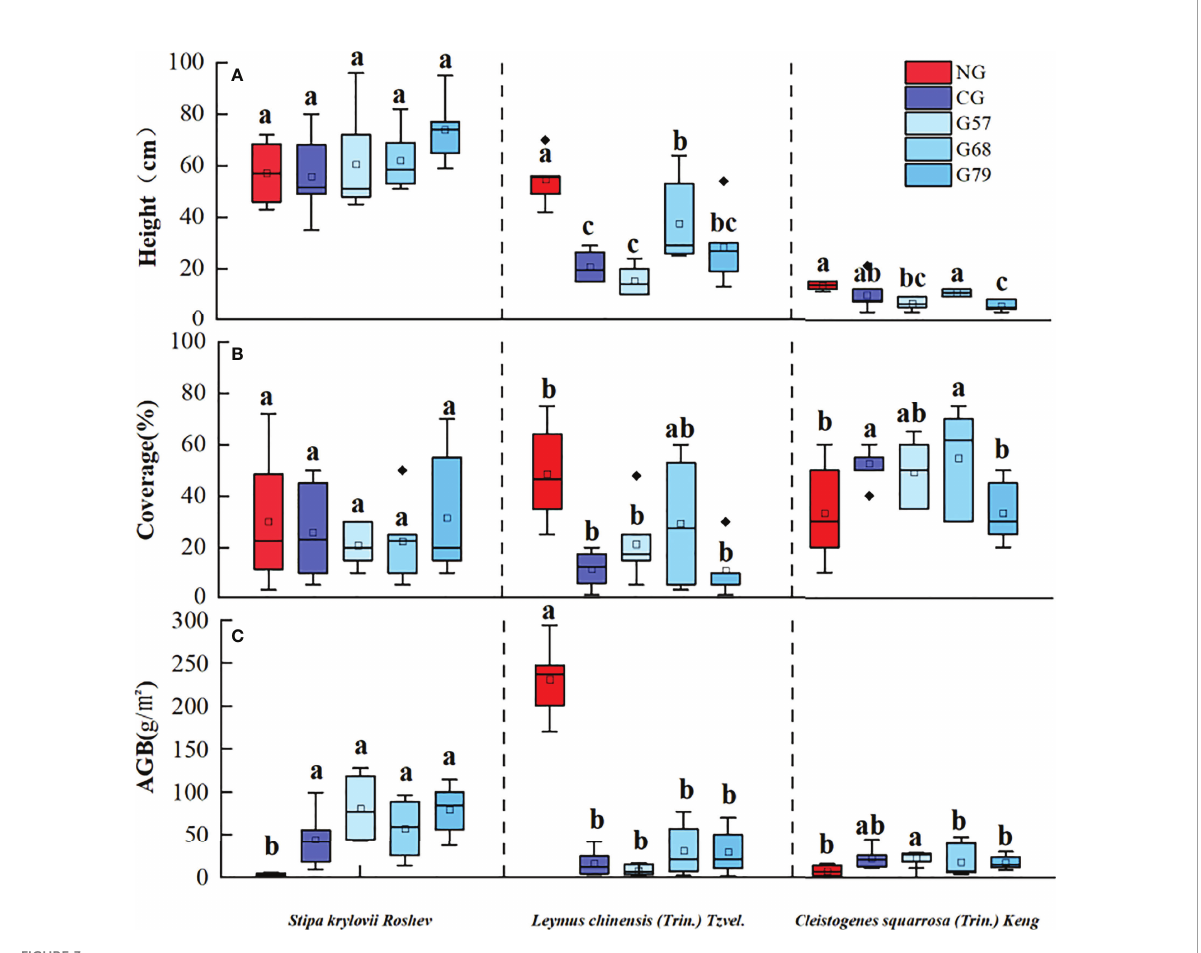
FIGURE 3 Grassland community characteristics in fi ve grassland management treatments: (A) height, (B) coverage, (C) AGB. NG: No grazing; CG: Continuous grazing; G57: Grazing in May and July; G68: Grazing in June and August; G79: Grazing in July and September. The error bars in the fi gure represent the standard error, and the lowercase letters represent the signi fi cant differences ( P